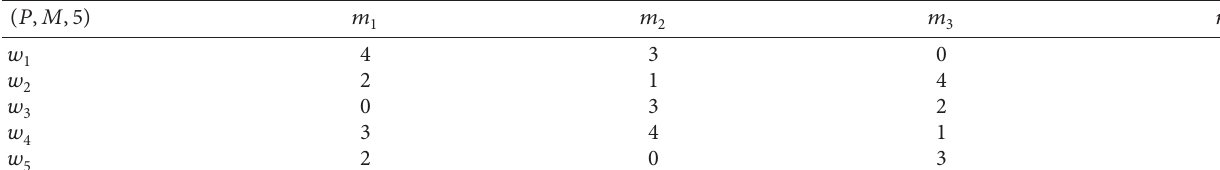
Table 3: Associated 5-soft